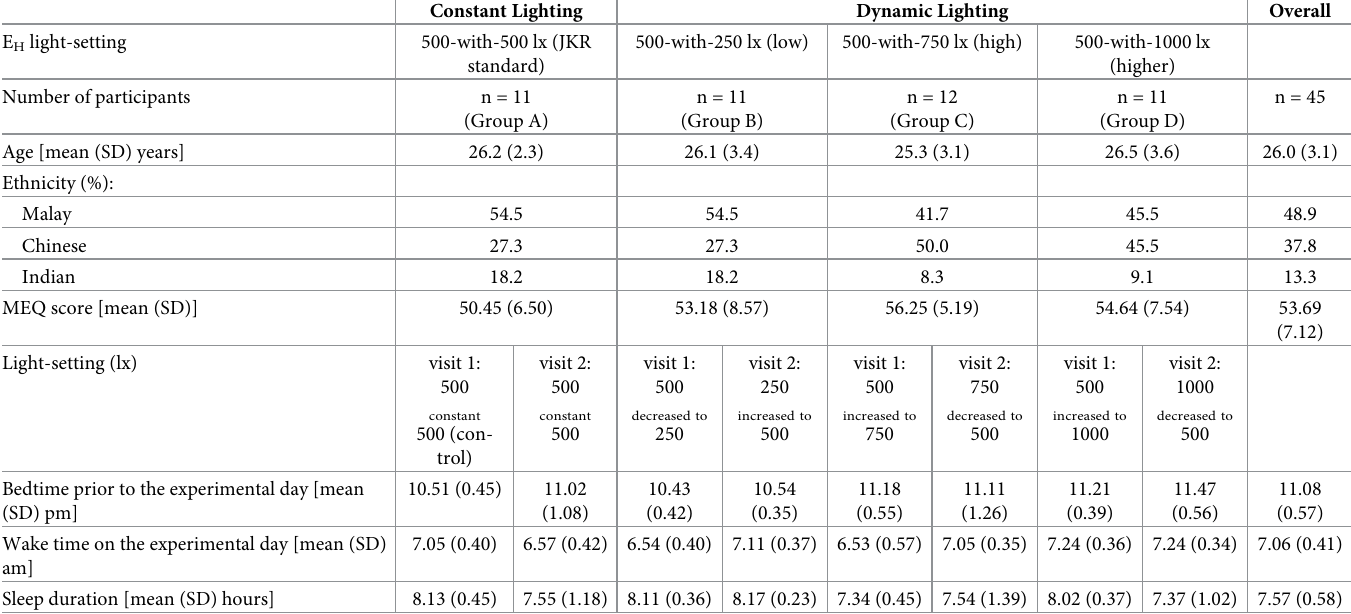
Table 2. Characteristics of participants in each E H